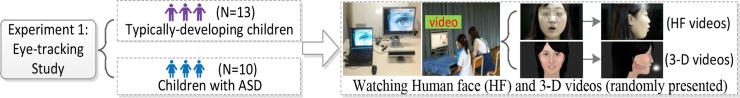
Procedure of the eye-tracking study in Experiment 1.